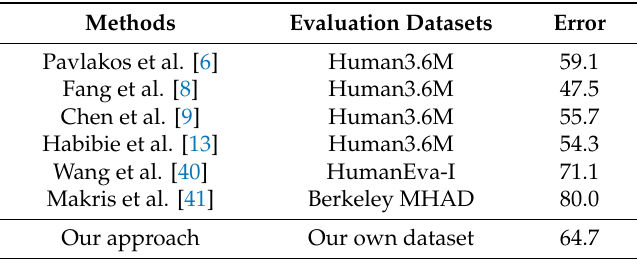
Table 5. 3D errors (mm) of 3D human pose estimation methods in the walking